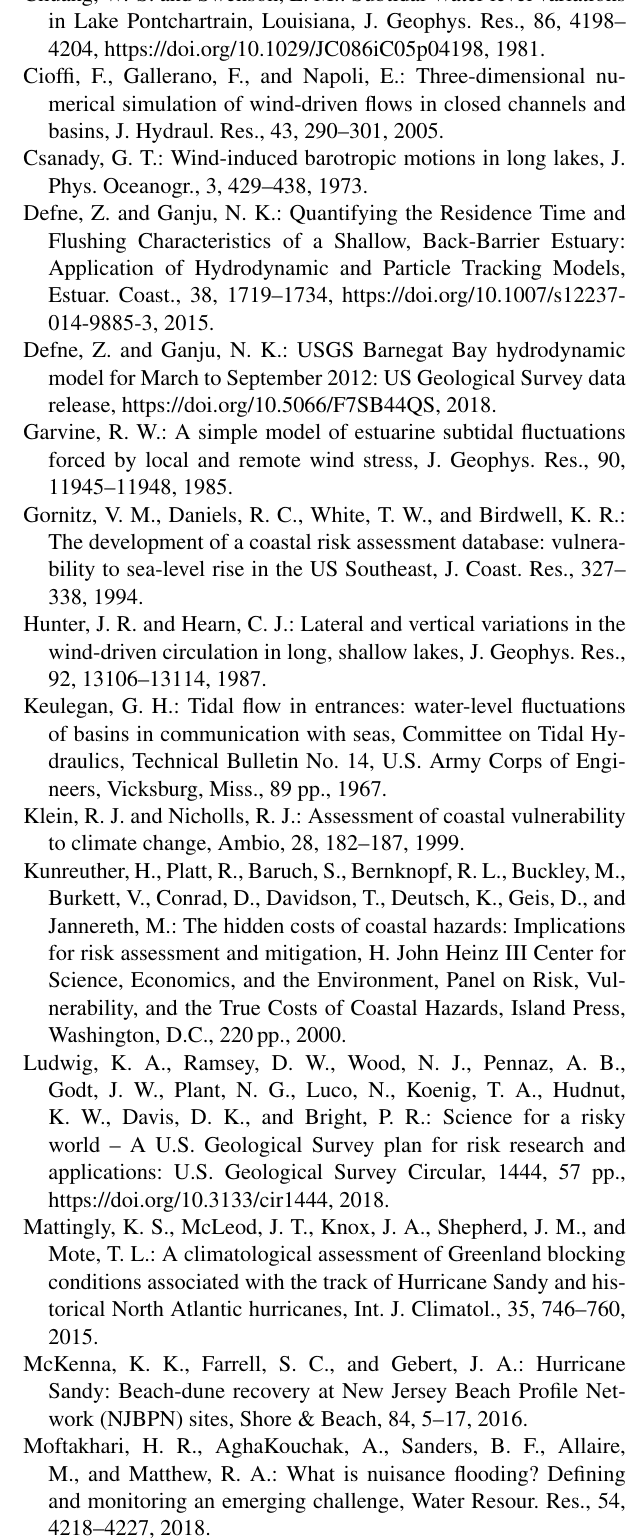
Table 1. The paper benefited from conversations with Chris Sher- wood, Tarandeep Kalra, and John Warner from